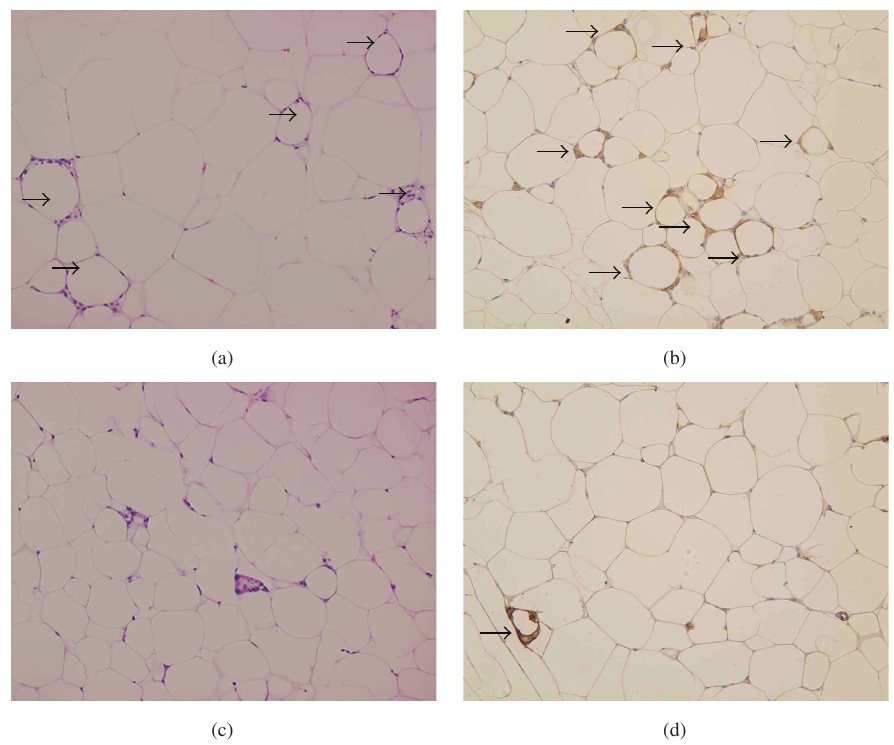
FIGURE 4: (a), (b) Visceral fat of control group. Adipocytes are markedly enlarged. Crown-like structures are frequently observed (arrows) ( × 200) ((a) H and E staining, (b) Mac-2 immunostaining as a macrophage marker) (c), (d) Visceral fat of HBOT group. Adipocytes are relatively small. Crown-like structures are rarely observed (arrows). ( × 200) ((c) H and E staining, (d) Mac-2 immunostaining as a macrophage